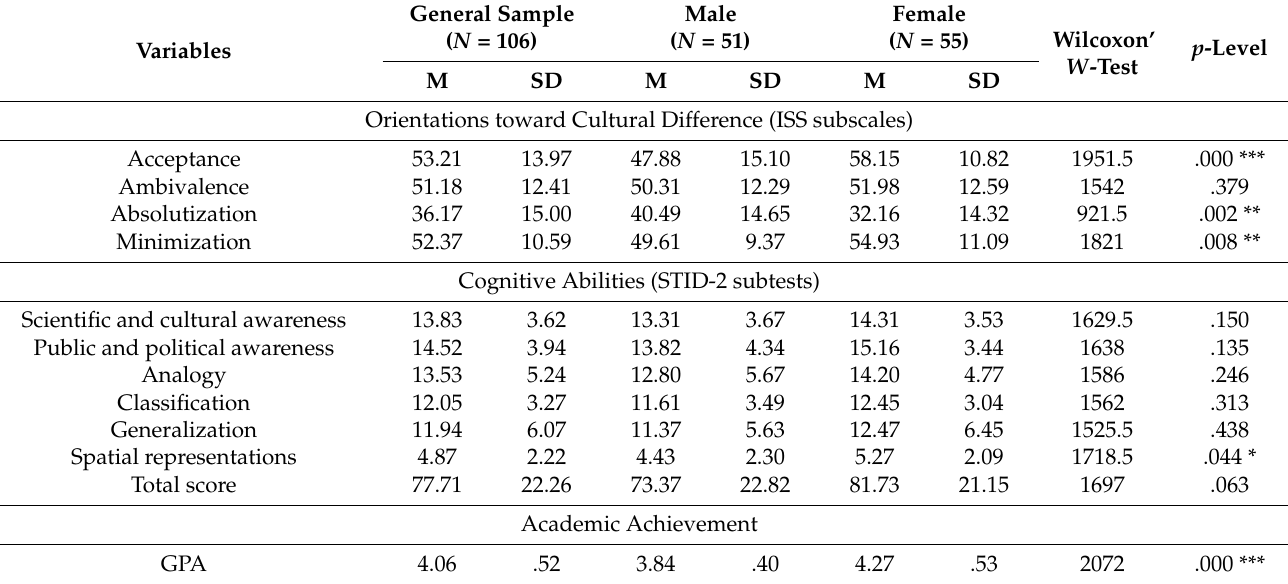
Table 1. Means (M), standard deviations (SD) and Wilcoxon’s rank-sum test with continuity correction ( W -test) between study variables in male and female school students.